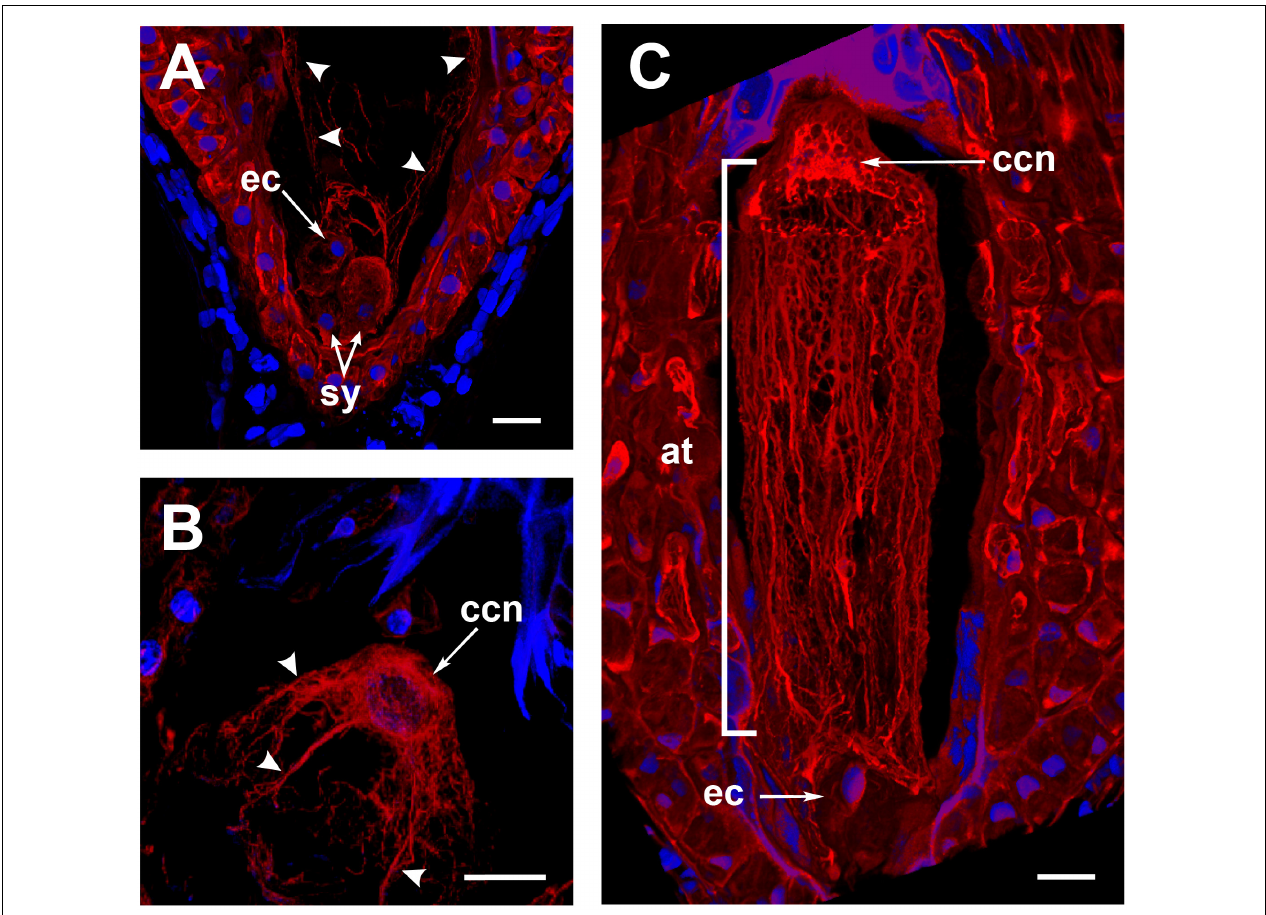
FIGURE 3 | The formation of the Agave inaequidens actin-tunnel. (A) Central cell F-actin starts accumulating at the cell body. (B) Actin filaments projected from the central cell nucleus toward the embryo sac micropylar pole (24–30 HAP). (C) Actin-tunnel formed by several parallel filaments extends from the central cell nucleus to the micropylar pole, next to the egg cell (32–36 HAP). ec, egg cell; sy, synergid; ccn, central cell nucleus; at, actin tunnel. Arrowheads in (A,B) = actin filaments. In all cases, F-actin was stained with rhodamine-phalloidin. Nuclei were stained with Hoechst 33258. All micrographs are z-stack projections oriented with the chalazal pole at the top. Bar in (A–C) = 20 µ